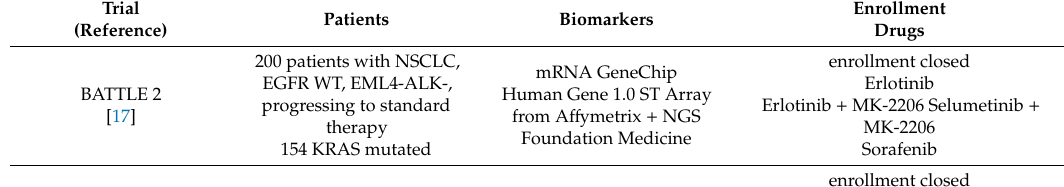
Table 2. Studies exploring NGS in patients with solid tumors and non-small cell lung cancer (NSCLC). Trial